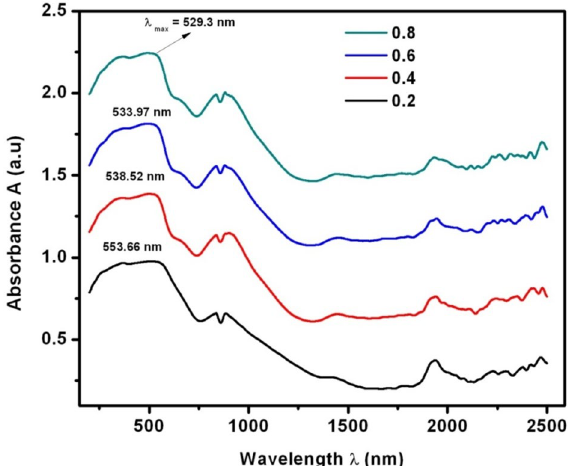
Figure 7. DRS spectra of SLFO nanoparticles.